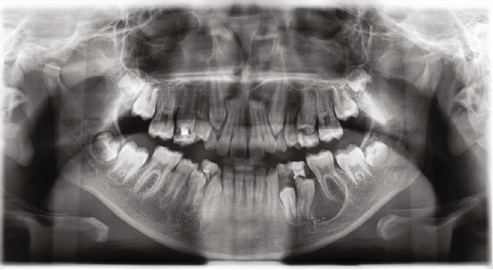
Figure 1: Pre-Op Orthopantomograph showing a well-de fi ned radiolucent lesion in the left posterior